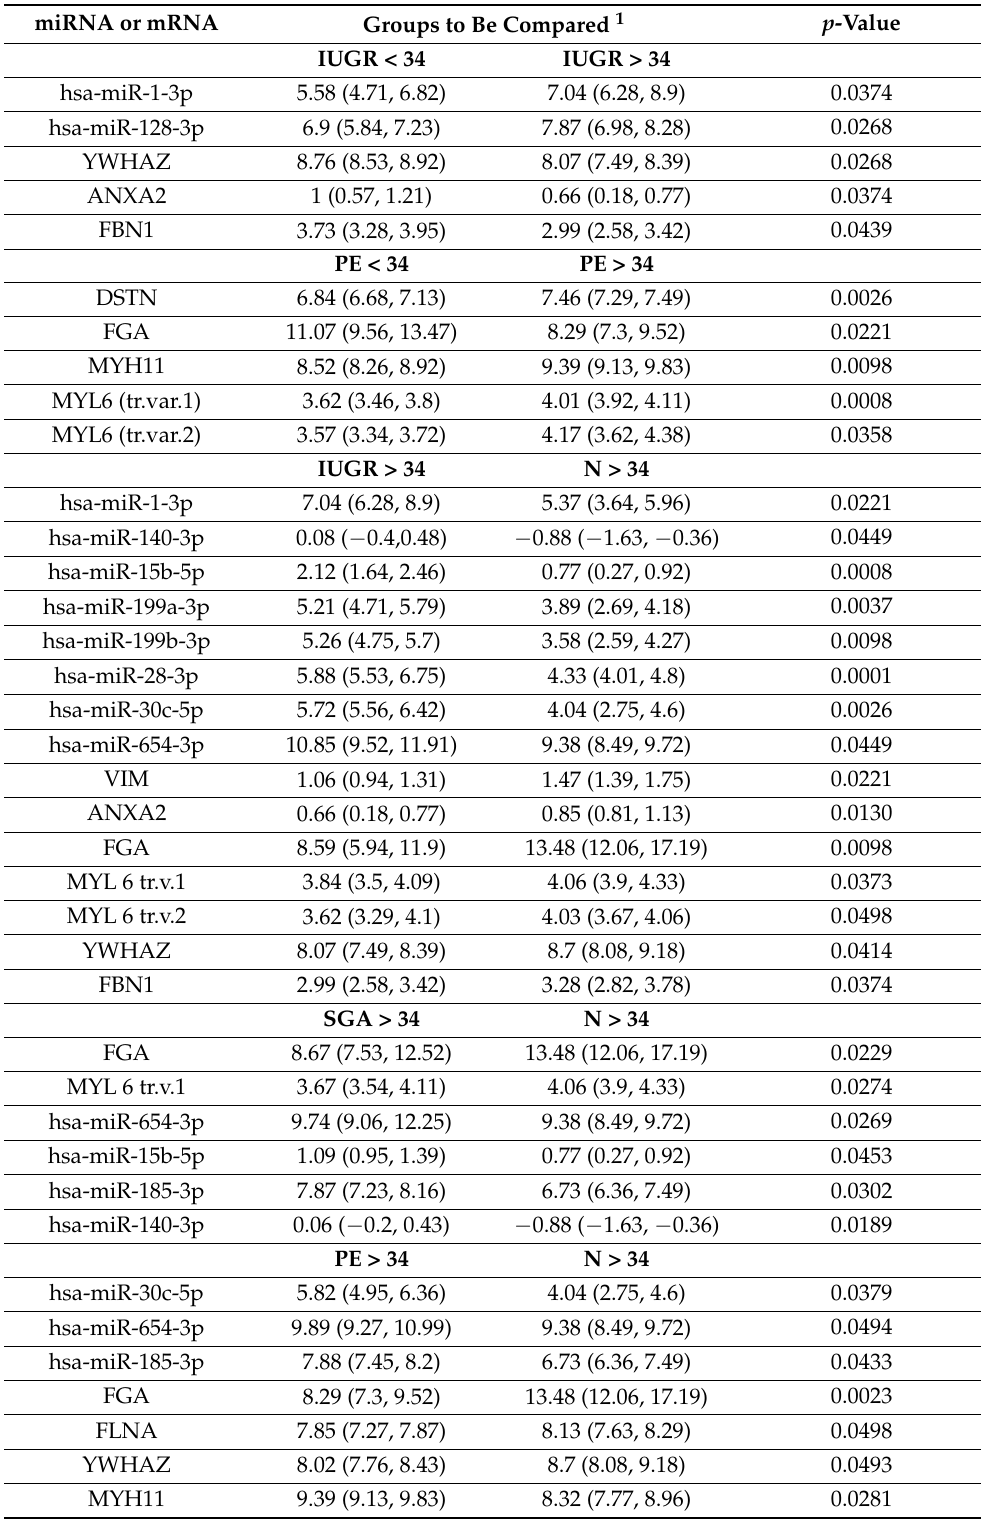
Table 3. Pairwise comparison of groups with IUGR, PE, SGA, and control group N by expression level of miRNA and mRNA obtained in